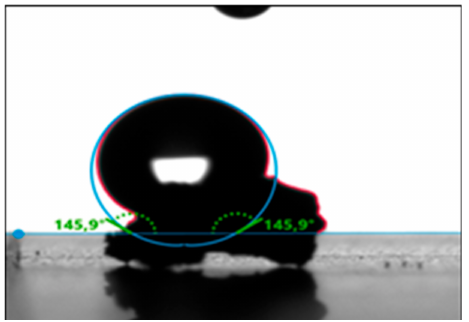
Figure 22. Rubber contact angle under the third treatment (R3), 145.9 ◦ .